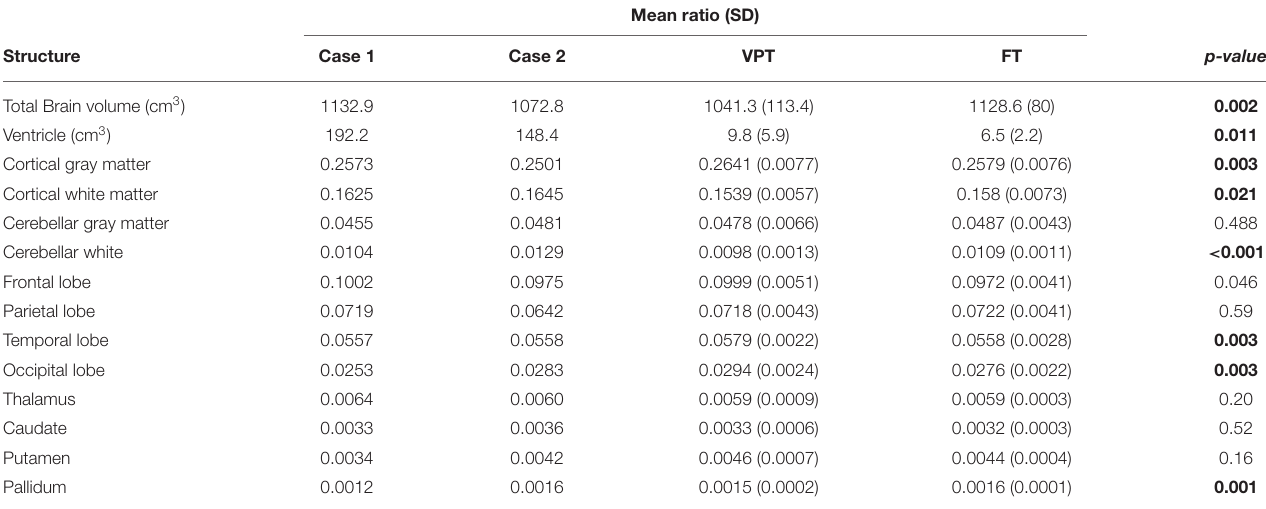
TABLE 3 | Average volumes adjusted for total brain volume at 4 years of